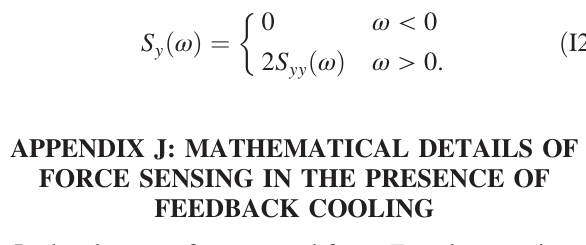
) and different c